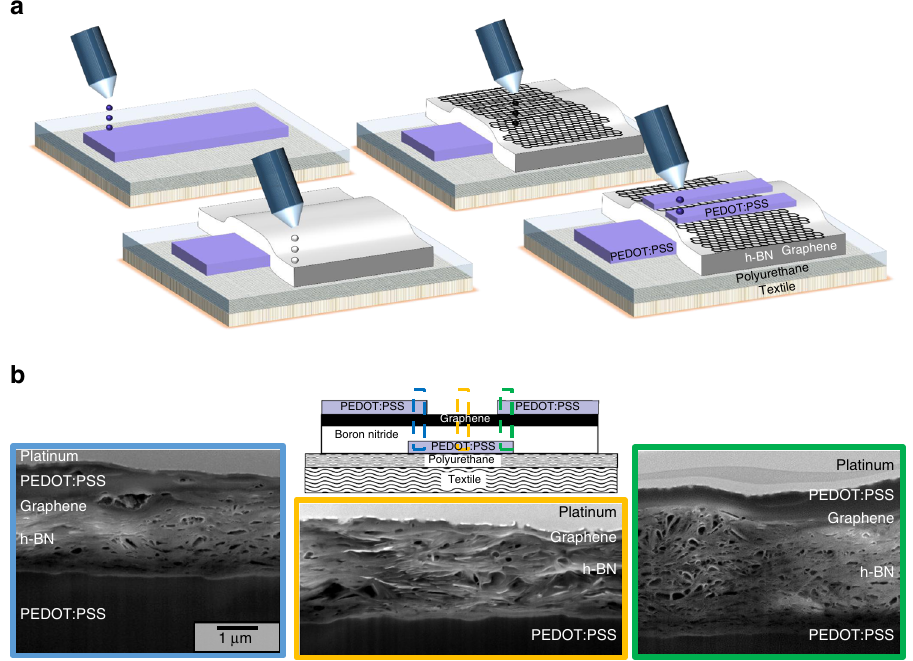
Fig. 4 Inkjet-printed FET on textile. a Fabrication steps of the inkjet-printed inverted-staggered FET heterostructure on textile. b FIB-SEM cross-sectional view of the full FET of the left contact (blue), middle channel (orange), and right contact (green). The scalebar is alike for each fi